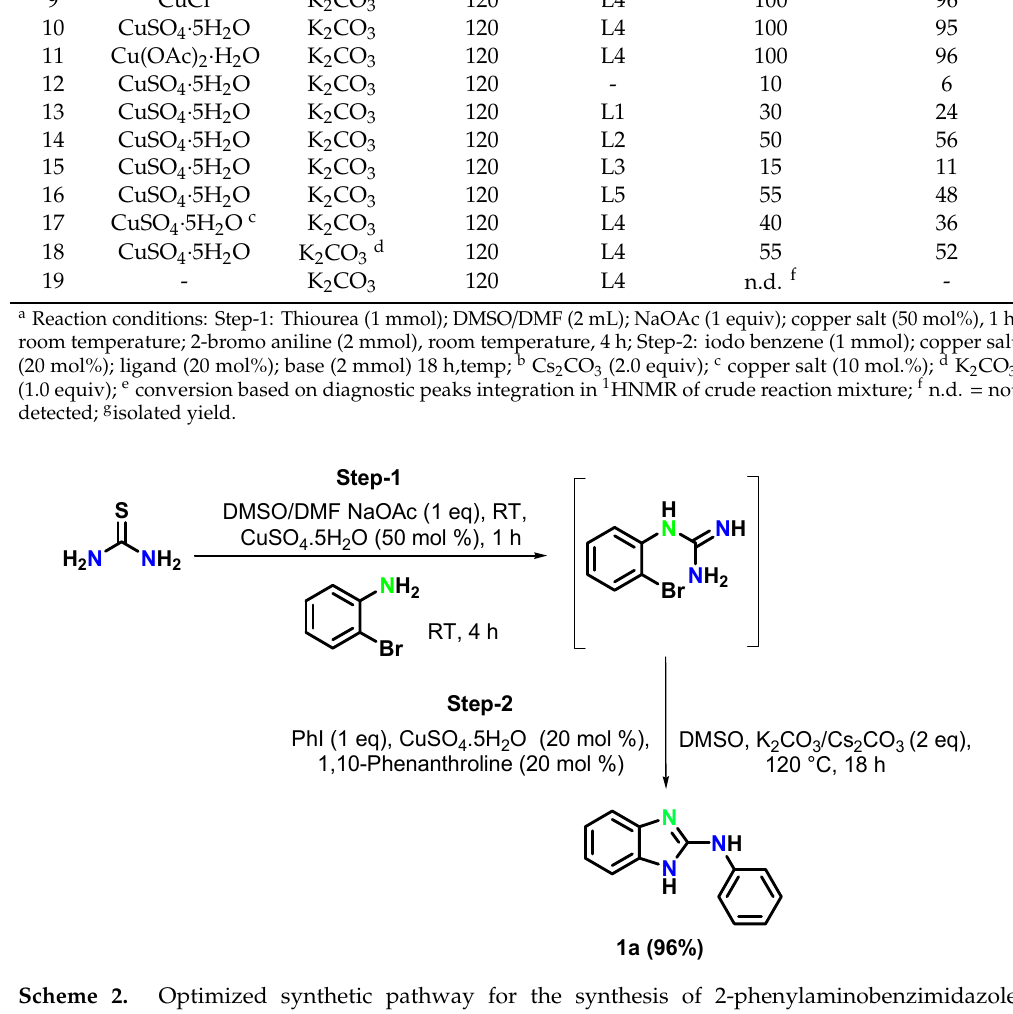
Scheme 2. Optimized synthetic pathway for the synthesis of 2-phenylaminobenzimidazole